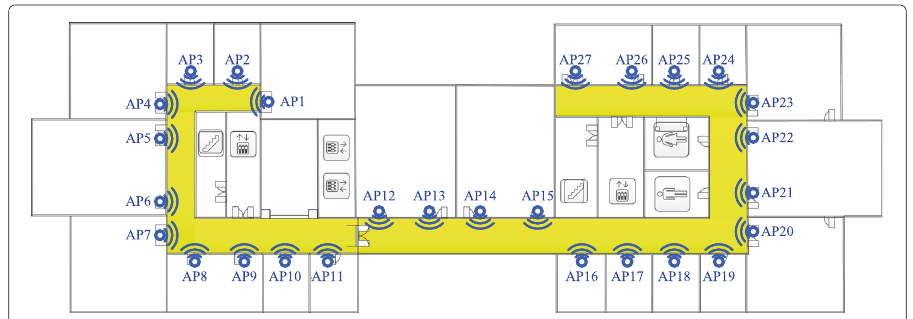
Fig. 10 Floor plan for indoor localization, where the area colored in yellow is used for testing